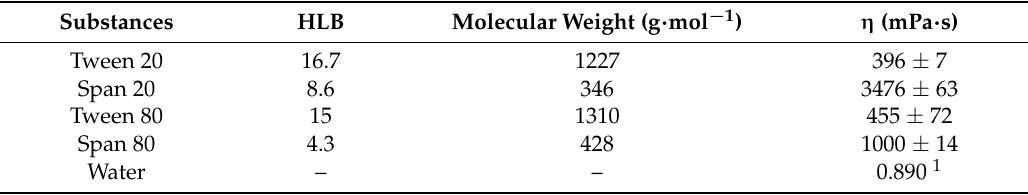
Table 3. Dynamic viscosity η of pure emulsifying agents and water (here: the continuous phase) at 25 ◦ C at a constant shear rate of 100 s − 1 .